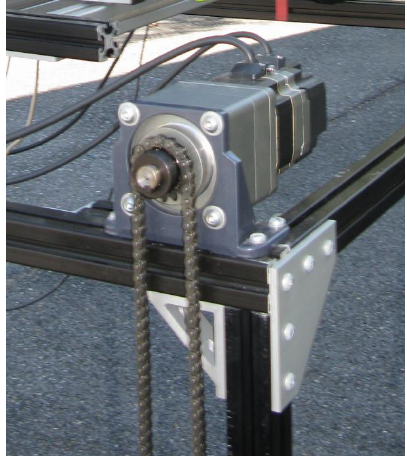
Figure 2. Motor mount and drive.